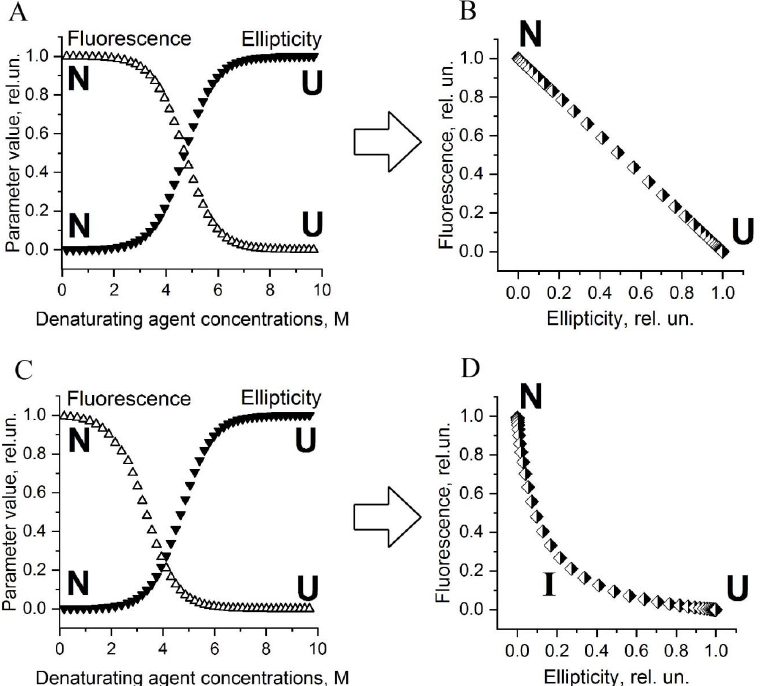
Figure 1. Schematic representation of typical transition curves used to study the equilibrium un- folding of protein ( A , C ) and corresponding parametric plots ( B , D ). Transition curve reflects the dependence of some experimental characteristic of protein sample on denaturant concentration ( A , C ). In the parametric plots ( B , D ), each point is a combination of two experimental characteristics of sample measured at a certain denaturant concentration. ( A , B ) are the graphs for a protein which fold/unfold without the formation of intermediate states. ( C , D ) are the graphs for a protein which fold/unfold through the formation of one intermediate state. N, I, U denote parts of the graphs characterizing the native, intermediate, and unfolded states of the protein, respectively. If protein folding/unfolding occurs via a single stage (i.e., without formation of in- termediate states), then the dependences of the different parameters on the denaturant concentration are sigmoidal curves with similar characteristics (midpoints and slopes) (Figure 1A). Moreover, if the curves plotted for various parameters have different char- acteristics, like is shown in Figure 1C, this indicates the presence of an intermediate state(s) during folding/unfolding of the protein. Such a noncoincidence of transition curves is easy to detect on ideal curves that are strongly shifted relative to each other (like in Figure 1C), but it is much more difficult for raw data with scattered experimental points. The analysis of such curves is simplified by constructing a parametric plot or, in other words, the graph of correlation between parameters. The examples of the de- pendence of fluorescence intensity on ellipticity for two cases are shown in Figure 1B,D. One can see that the shape of the parametric curve changes significantly if there is an in- termediate state during protein folding, i.e., the curve bending on the parametric plot